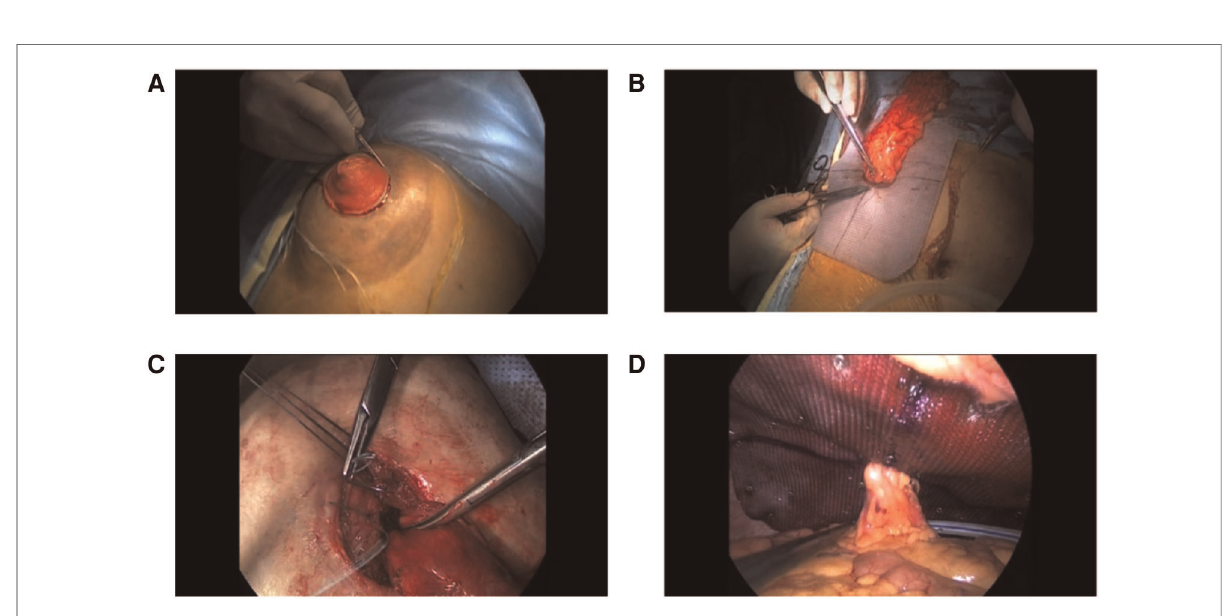
FIGURE 6 lap-redo+Keyhole ( A ) In situ incision; ( B ) Redundant stomal bowel is pulled out from the abdominal cavity, and the mesh is stitched to the sero muscular layer of the stomal tube; ( C ) Closure of the hernia ring under direct vision; ( D ) Intraoperative view of the fi xed mesh and colostomy.